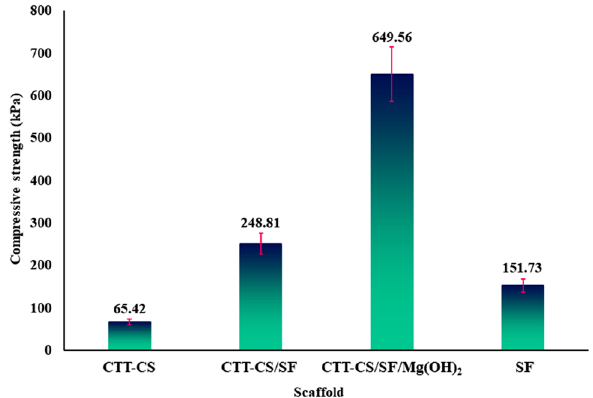
Figure 6. Compressive strength of the scaffolds from the four groups. Data represent the mean ± SD (n =